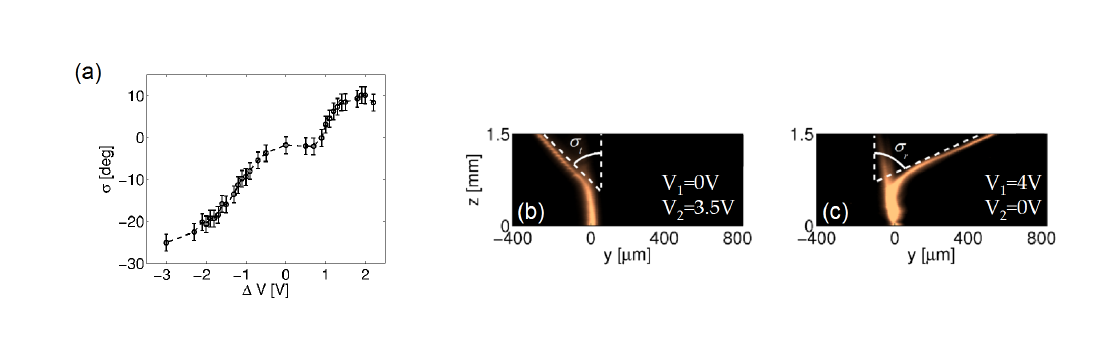
Figure 11. ( a ) Overall deflection obtained with a nematicon at grazing incidence versus bias (cid:0) V < V > V difference ∆ V = V , with V ( V ) vanishing when V ( V ); ( b ) Refracted 1 2 1 2 1 2 1 2 and ( c ) totally internally reflected nematicon with an angle of incidence of (cid:25) 16 (cid:14) with ˆ z ; In ( c ), some losses are appreciable, owing to the abruptness of the dielectric barrier. This launch condition maximizes the deflection, reaching σ (cid:25) 55 (cid:14) .